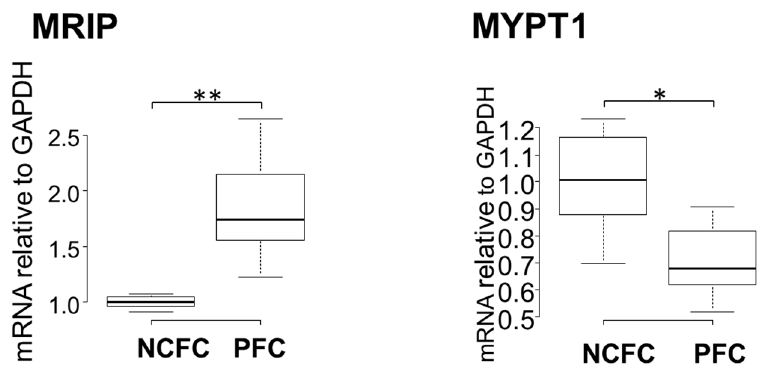
Figure 7. qPCR quantification of NCFCs and PFC mRNA expressions of MRIP and MYPT1 relative to GAPDH ( n = 4). The relative mRNA expression of MRIP was significantly higher in PFCs than in normal conjunctiva tissue. The relative mRNA expression of MYPT1 was significantly lower in PFCs than in normal conjunctiva tissue. * p < 0.05 and ** p < 0.01.